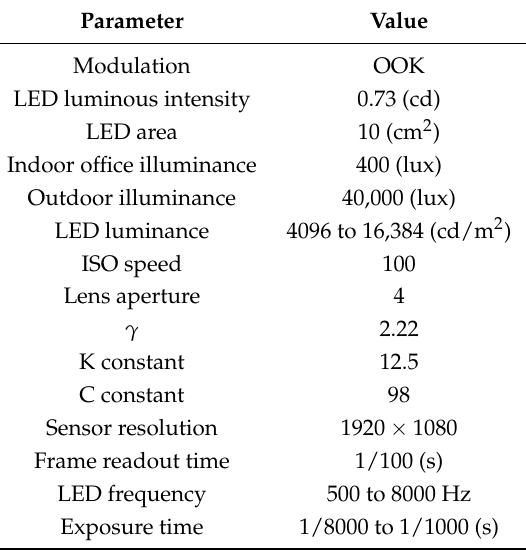
Table 2. Simulation environment.